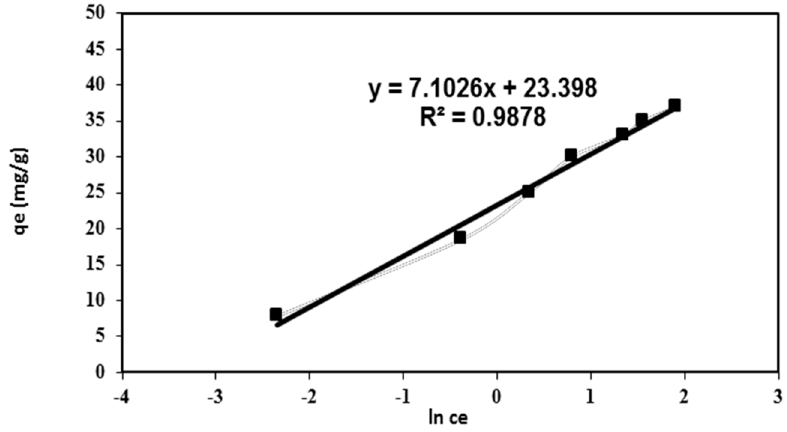
Figure 7. Temkin adsorption isotherm for BV 14 dye adsorption onto the chemically modified nanofibers.